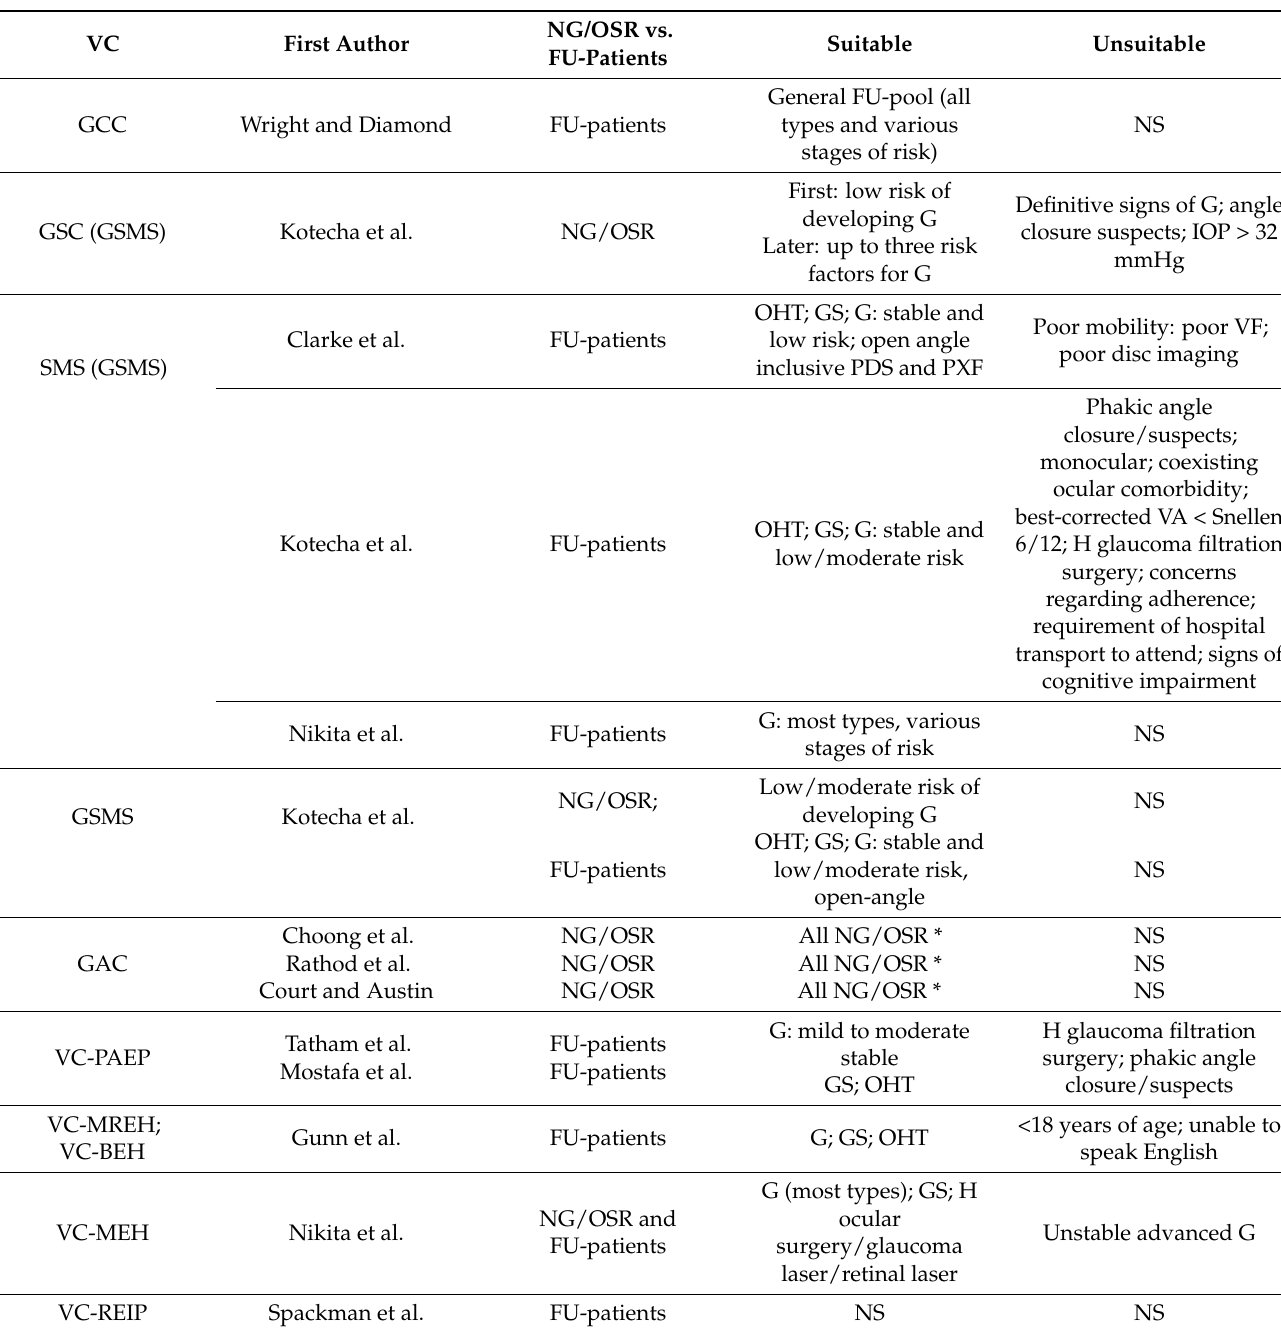
Table 7. The characteristics that render patients suitable or unsuitable for each virtual